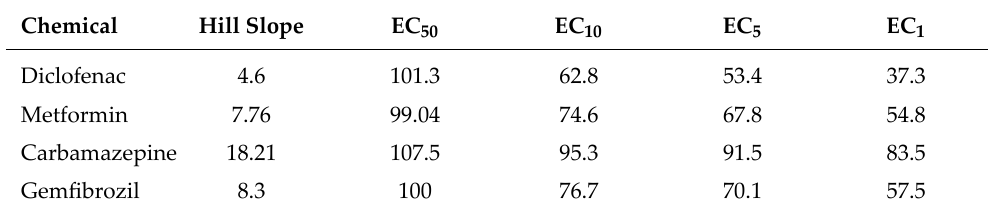
Figure 1. Toxicity curves of pharmaceuticals. Twenty neonates (<24 h) were exposed for 24 h to di‑ clofenac, metformin, carbamazepine and gemfibrozil in 50 mL OECD media. Data represent average ± SD (N = 4) for each concentration. Table 1. Effect concentration in mg/L for diclofenac, metformin, carbamazepine and gemfibrozil, calculated for neonates exposed to pharmaceuticals for 24 h.* The Hill model used is provided in Materials and